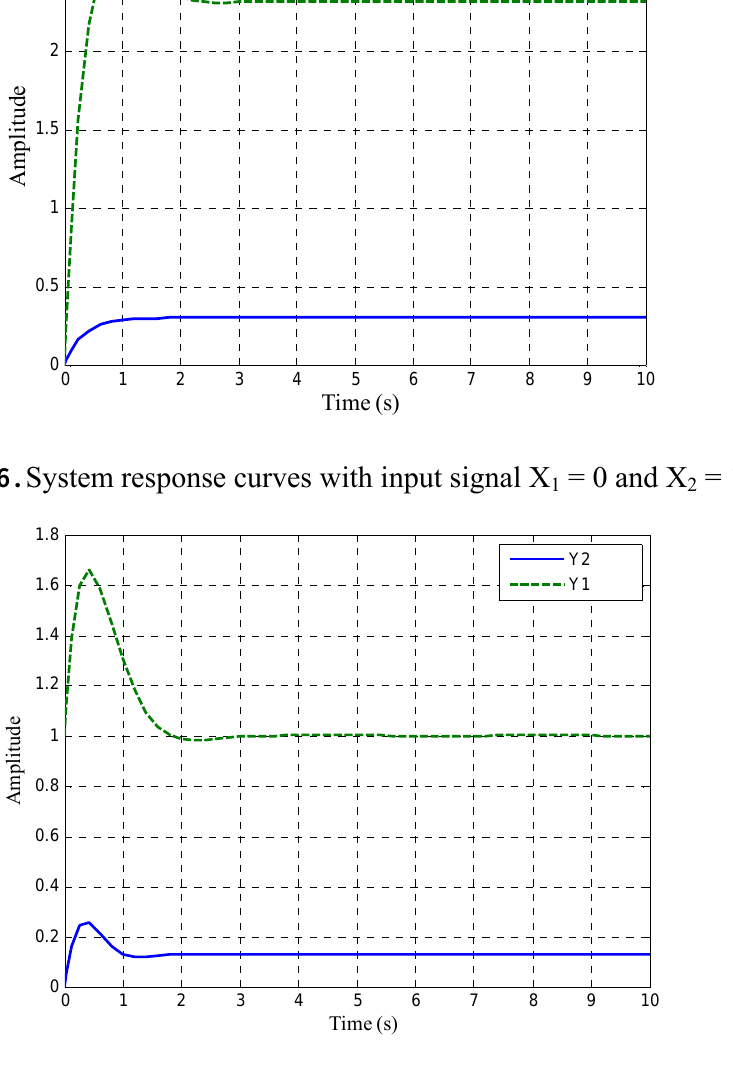
Figure 5. System response curves with input signal X